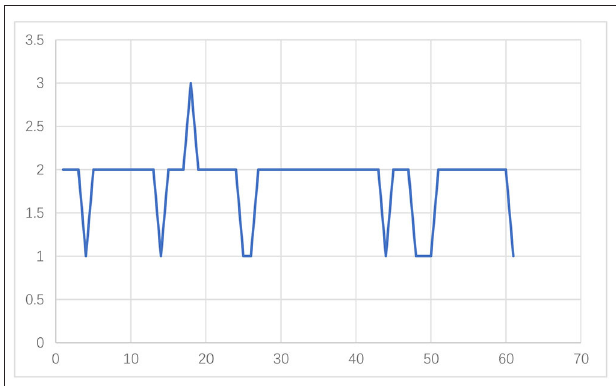
FIGURE 7 | Monthly grade results based on ID-FCE (July 2016-July